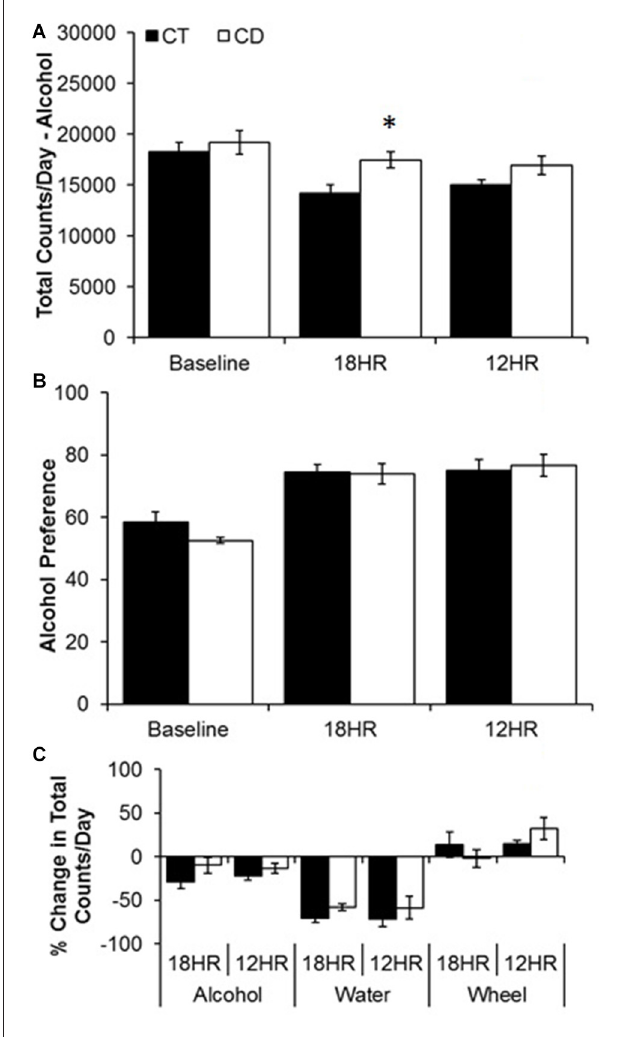
FIGURE 3 | Analysis of overall changes in alcohol and water intake during baseline alcohol access and 18HR environmental CD. Mice in CD drank significantly more alcohol than controls in the total 24-h cycle of 18HR photoperiods (ignoring light and dark; A ). Although alcohol preference increased over time (B) there was no effect of CD and the increase was due to a significant decrease in water intake in both groups (C) (data indicate the mean ± SEM for n = 6; asterisks indicate significant differences between control and CD